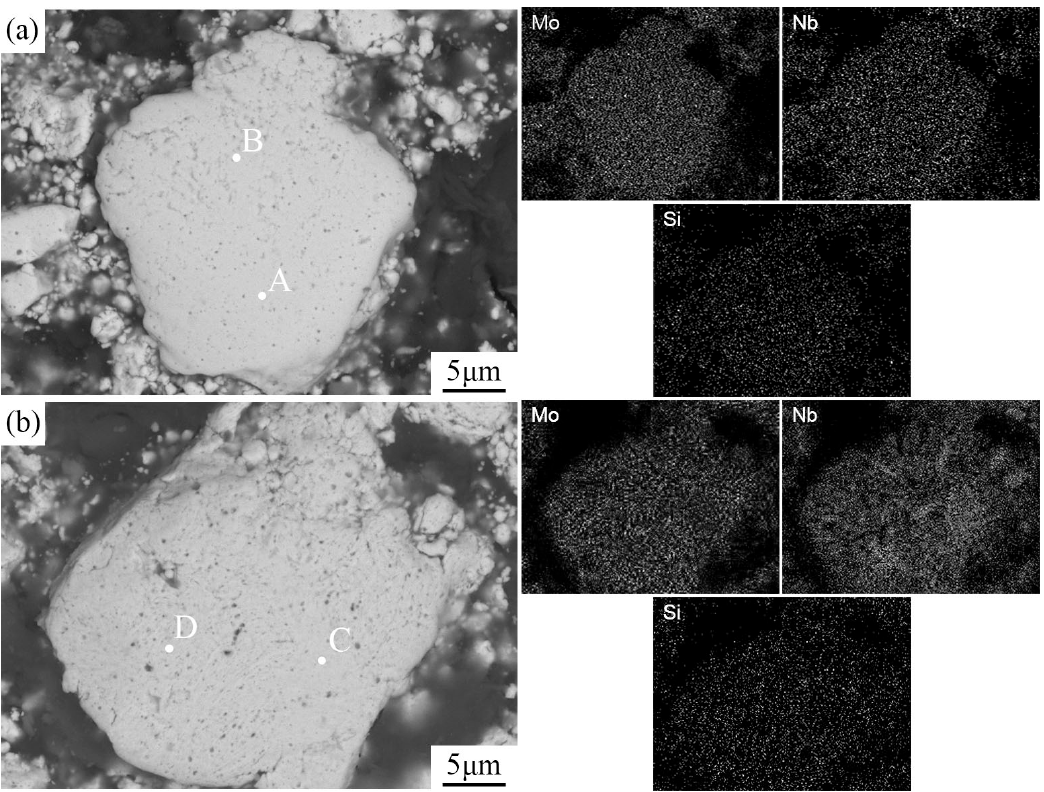
Figure 2. Cross-sectional BSE images of samples ( a ) MA-10Nb / 50h and ( b ) MA-20Nb / 50h, and their corresponding EDS mapping results.